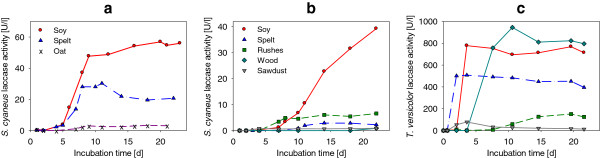
Laccase activity in the culture supernatants. (a)S. cyaneus cultivated in modified ISP9 medium with soy flour, spelt flour and oat bran as carbon sources, (b)S. cyaneus cultivated in secondary treated sterile municipal wastewater with soy flour, spelt flour, rushes pieces, ash branches pieces (wood) and beech sawdust, and (c)T. versicolor cultivated in treated wastewater with the same carbon sources.